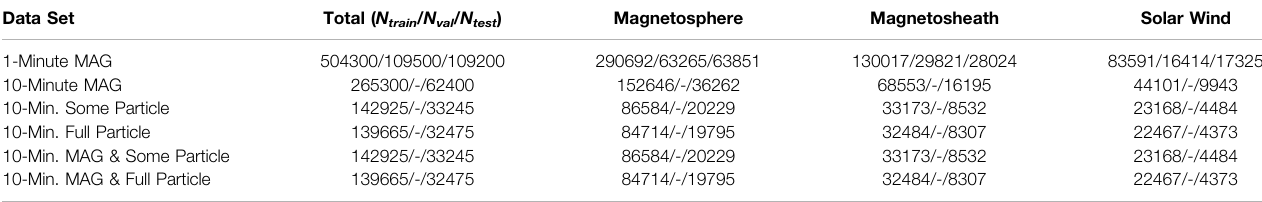
TABLE 1| Number ofsamplesin each region forthe training, validation and test sets. Note that for the 10-min interpolated data sets, which were only used by the SVM, RF, andLRclassi fi er,avalidationdatasetwasnotused.Thetimespansofthetraining,validationandtestsetsremainedascloseaspossibleacrossthedifferentsetstoallow for intracomparison of the model